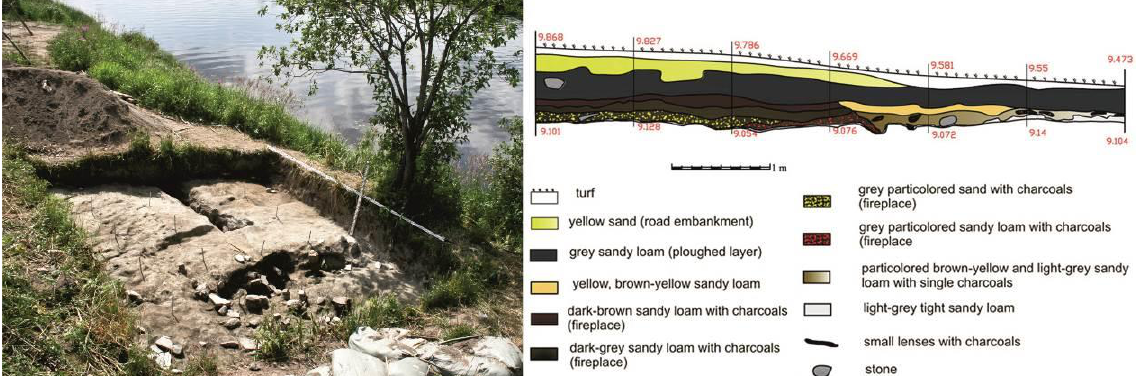
Figure 3. Trench on the workshop site Fofanovo XIII. Bottom of the cultural layer (north-east view) and eastern